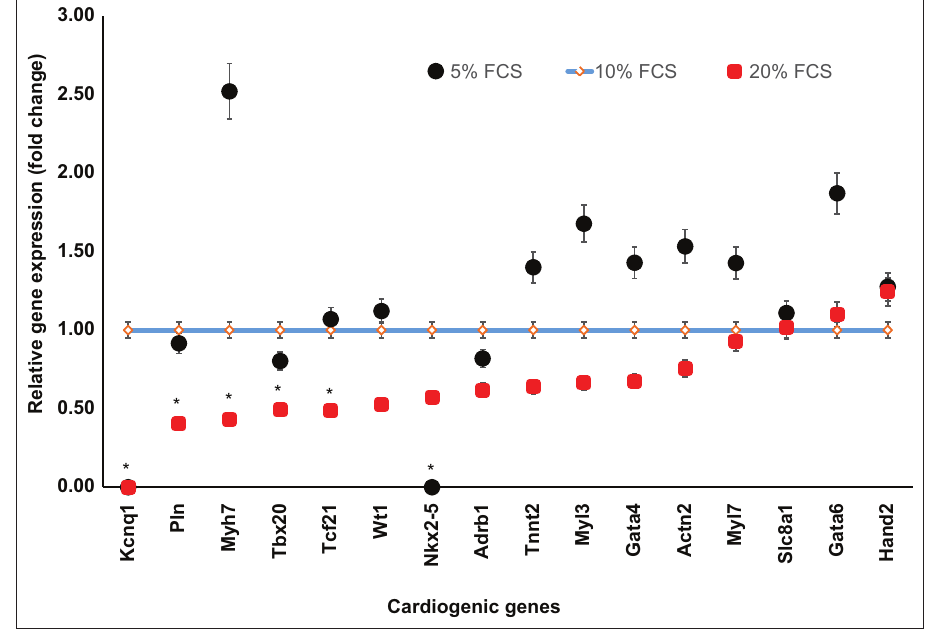
Figure-5: The effect of altered serum concentration in cultures of cardiac fibroblasts on cardiogenic gene expression. Gene expression of 10% fetal bovine serum culture (conventional culture) was set to 1, and the gene expression of culture in 5% and 20% serum was calculated relative to conventional culture. The result of reducing the serum to 5% in culture was variable, but adding the serum to 20%, tended to decrease gene expression of most cardiogenic genes. The expression of potassium voltage-gated channel subfamily Q member 1, phospholamban, myosin heavy chain 7, T-Box Transcription Factor 20, transcription factor 21, and NK2 homeobox 5 genes was significantly altered (p<0.05). Cell culture was done in six replications while quantitative polymerase chain reaction was done in three